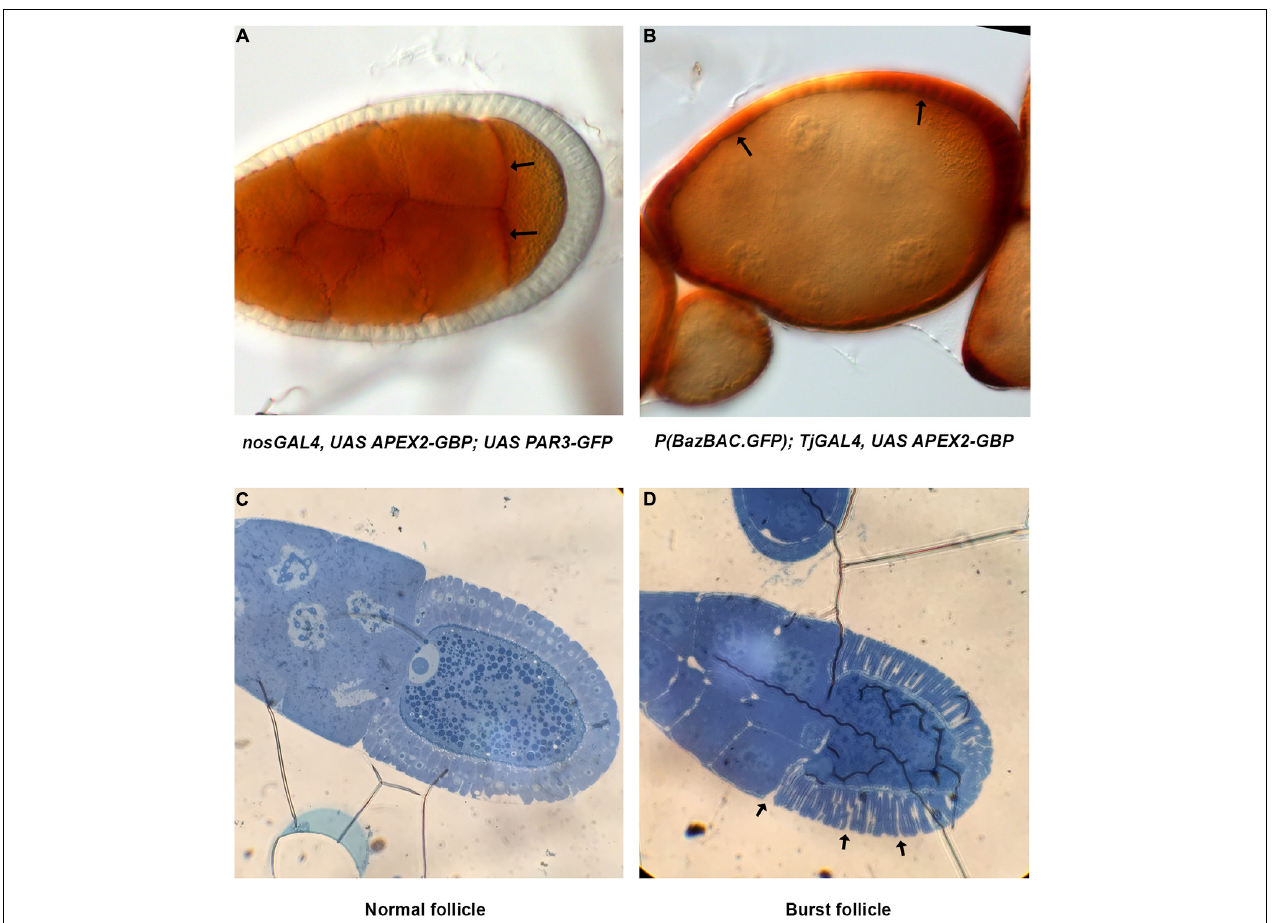
FIGURE 3 | Method validation. (A) Images of nos-Gal4 VP 16 , UAS-APEX2-GBP , UAS-Par3-GFP ovarian follicle acquired on transmission light microscope reveal DAB precipitates specifically in the germline. Stronger accumulation at the anterior of the oocyte (arrows) is coherent with Par3 distribution profile. (B) In P(Baz BAC . GFP ) ; UAS-APEX2-GBP/Tj-GAL4 , DAB staining is only observed in follicular cells (arrows). Note that the brown shade over the germline staining is due to surrounding follicular cells. (C,D) Methylene blue staining reveals morphology of the follicle and allows visualization of nuclei. Thereby, we can also verify the developmental stage of the egg chamber (C) . In addition, issue with fixation is also revealed by burst ovarian follicles [arrows, (D)